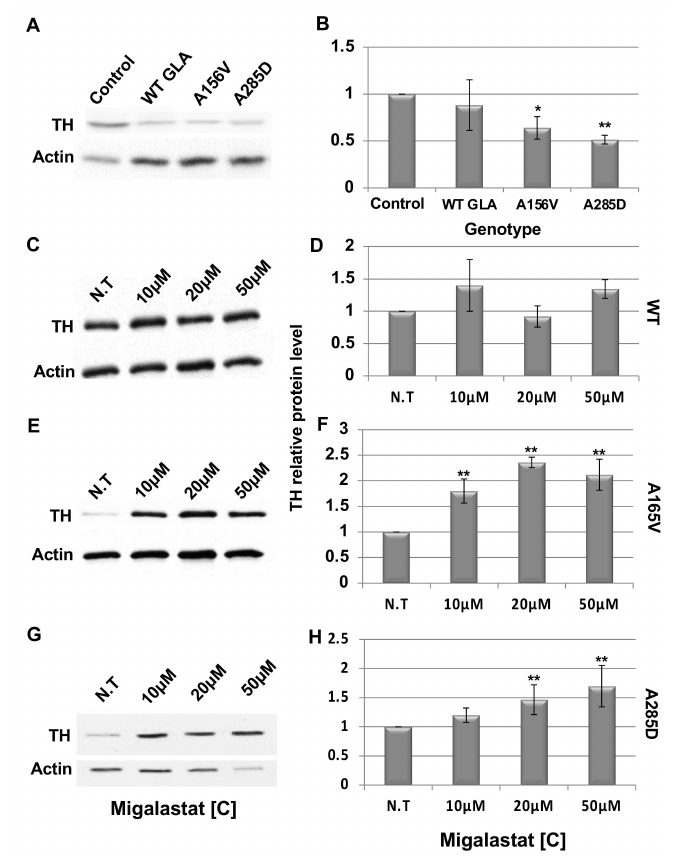
Figure 6. Western blot analysis of tyrosine hydroxylase in brains of GLA transgenic flies. ( A ) Protein lysates, prepared from heads of 10 control flies or flies expressing the di ff erent α -Gal A variants at day 22 post-eclosion, were subjected to Western blotting. The corresponding blots were interacted with anti-TH antibodies. As a loading control, the blots were interacted with anti-actin antibodies. ( B ) To quantify the results, TH intensity in each lane was divided by that of actin in the same lane, and the number obtained for Control was considered 1. Results represent the mean ± SEM of four independent experiments. Statistical analysis included one-way ANOVA with post-hoc Dunnett test. ( C , D ) Protein lysates prepared from flies expressing the WT α -Gal A, treated with the shown migalastat concentrations, were manipulated as in ( A ). To quantify the results, TH intensity in each lane was divided by that of actin in the same lane, and the number obtained for N.T. was considered to be 1. Results represent the mean ± SEM of four independent experiments. ( E , F ) Protein lysates prepared from flies expressing the A156V α -Gal A, treated with the shown migalastat concentrations, were manipulated as in ( A ). Quantification was as in ( D) . ( G,H ) Protein lysates prepared from flies expressing the A285D α -Gal A, treated with the shown migalastat concentrations, were manipulated as in ( A ), and quantification of results was as in ( D ). In ( D , F , H), statistical analysis included two-way ANOVA (to determine significant di ff erences between genotypes’ reaction to concentrations) followed by one-way ANOVA with post-hoc Dunnett t-test. Significance: * p < 0.05; ** p < 0.01. N.T: Non-Treated. The expression of the α -Gal A mutant variants was under the dopa decarboxylase GAL4 driver